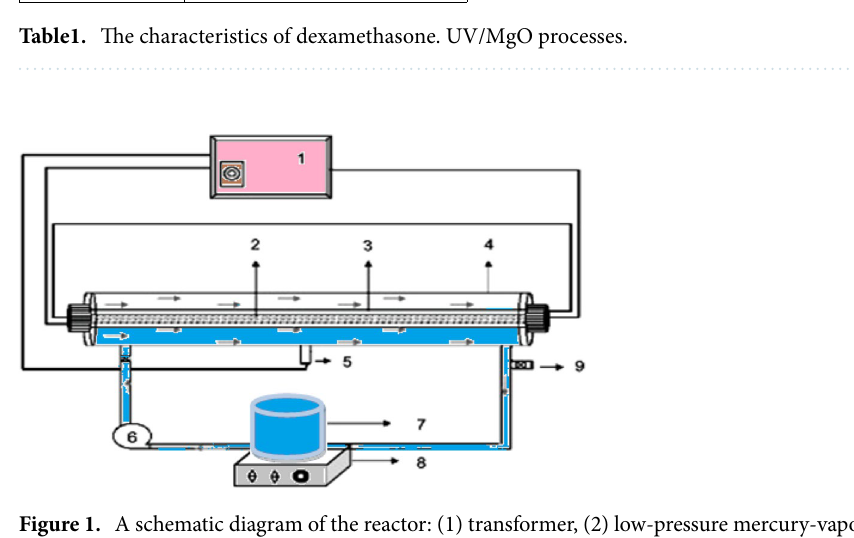
Figure 1. A schematic diagram of the reactor: (1) transformer, (2) low-pressure mercury-vapor UV lamp, (3) quartz cover (L: 85 cm D: 5 cm), (4) stainless steel box (L: 85 cm, D: 8 cm), (5) photocell, (6) pump (50–400 ml/ min), (7) beaker (2 L), (8) shaker, and (9) sampling